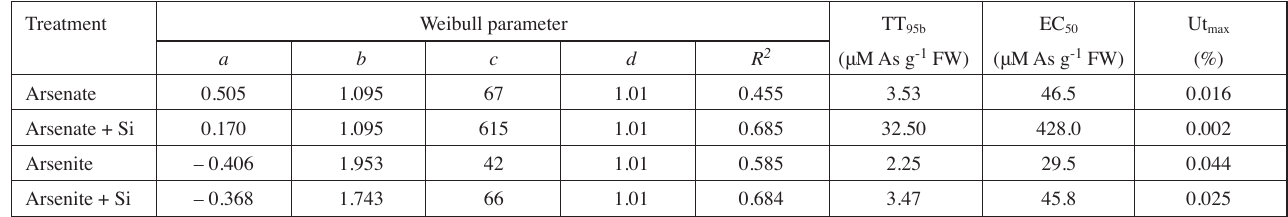
Tab. 1: Assessing response of fresh weight increase of lettuce to various combinations of arsenite or arsenate with potassium silicate using the modified Weibull function (see Calculations and statistics). Treatment